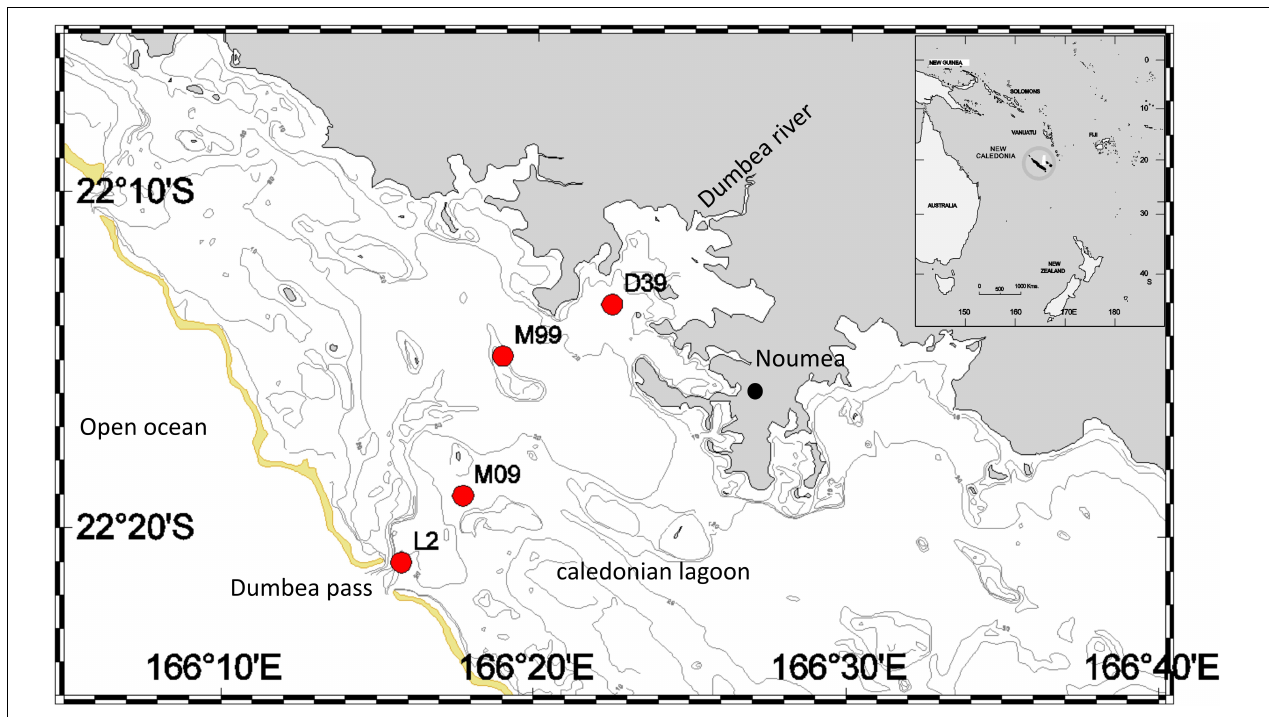
FIGURE 1 | Map of the study site in the New Caledonian lagoon (Western Tropical South Pacific), including stations L2, M09, M99, and